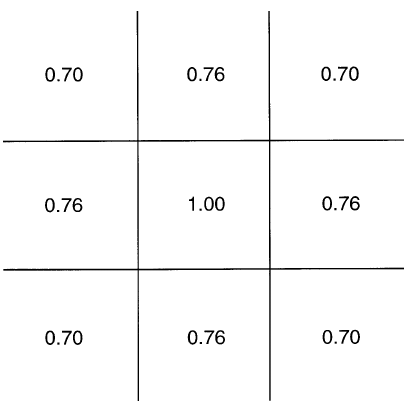
Fig. 4. In the grid boxes the coefficients (cid:107) ( r ) (cid:111) are